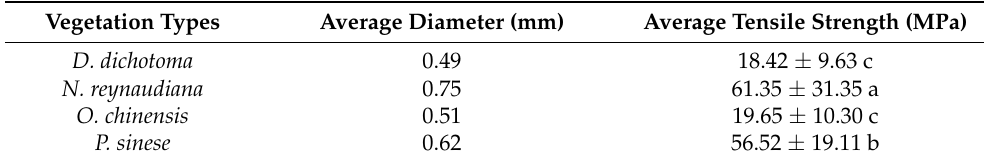
Table 6. Average tensile strength of different vegetation types.